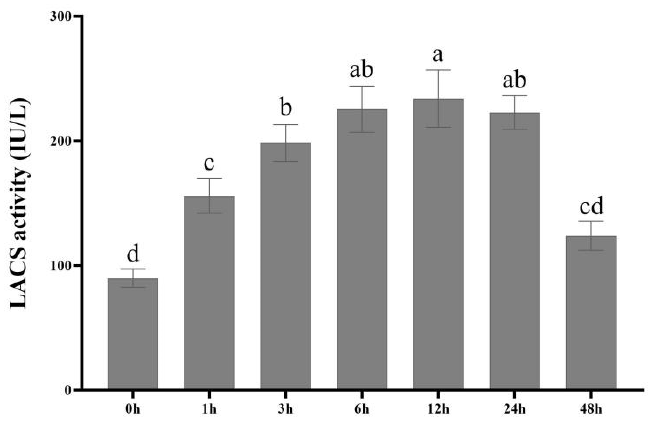
Figure 4. LACS enzyme activity from mature leaves induced by PEG.